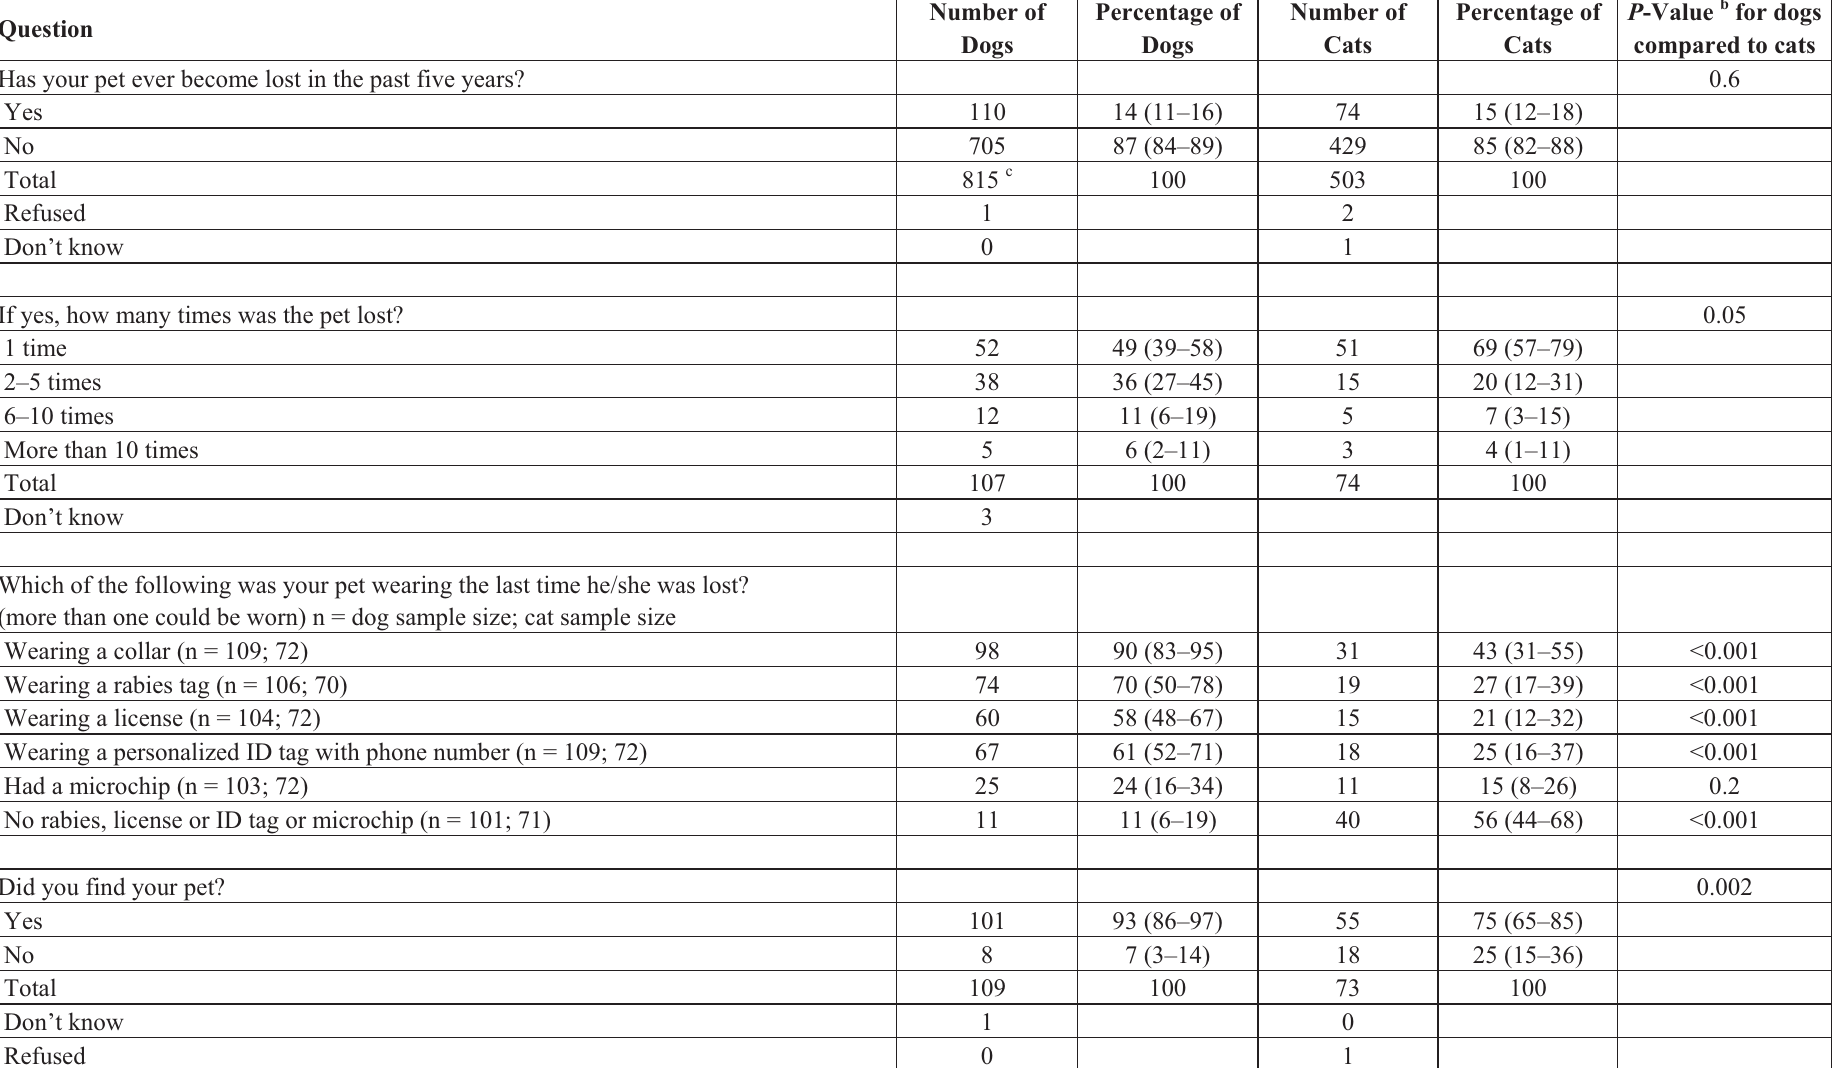
Table 1. A national survey of 1,014 households owning dogs or cats in the past five years a .